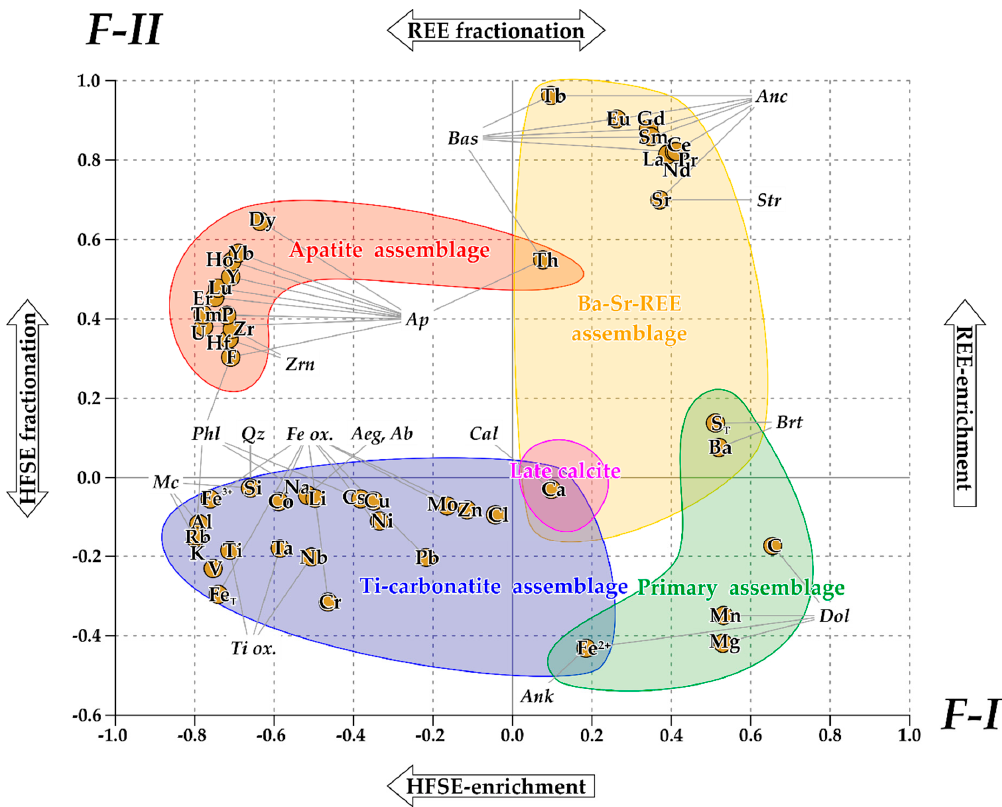
Figure 18. Points of the studied major and trace elements on the factor plane formed by the two factors with maximum eigenvalues. The colored fields distinguish the groups of elements associated with certain minerals from one or other mineral assemblages. Illustration is based on the work of